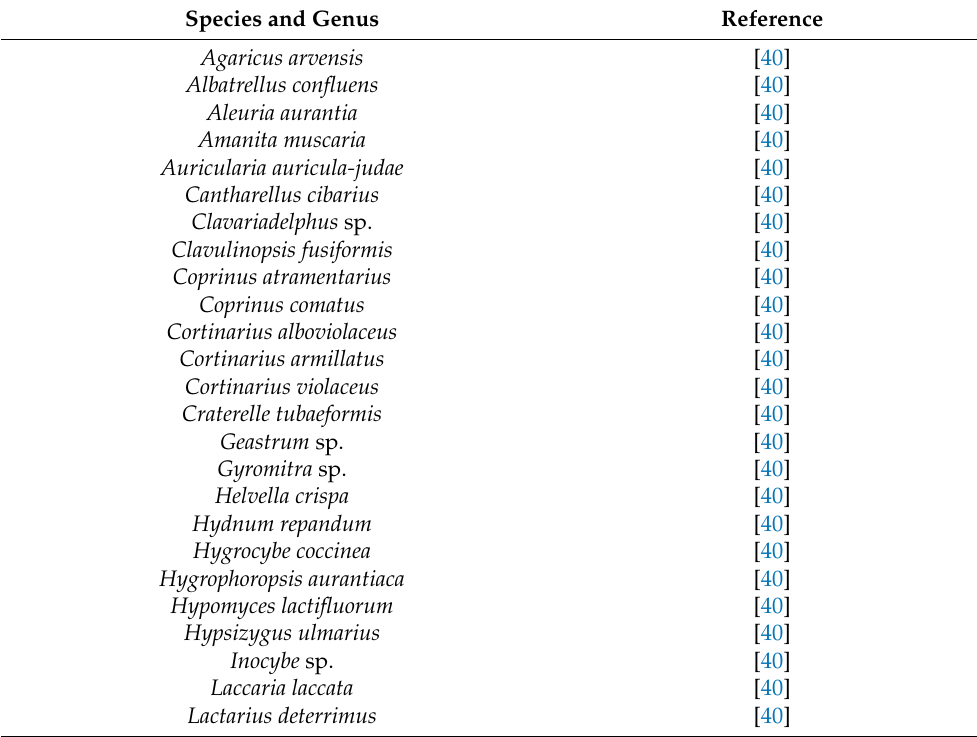
Table A6. Fungal species and genus (including lichens) observed on Anticosti Island (Qu é bec, Canada) according to the Anticosti Island monograph and personal observations of Dani è le Morin